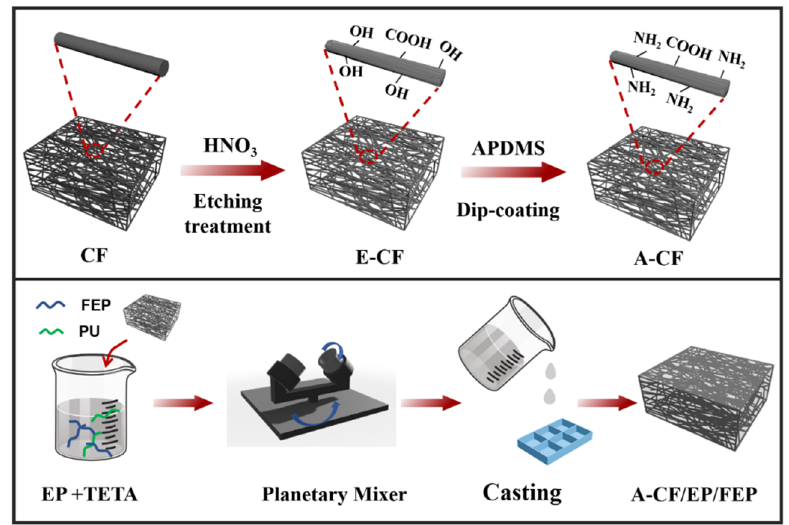
Figure 1. Schematic of the fabrication process of the A-CF/EP/FEP composites.